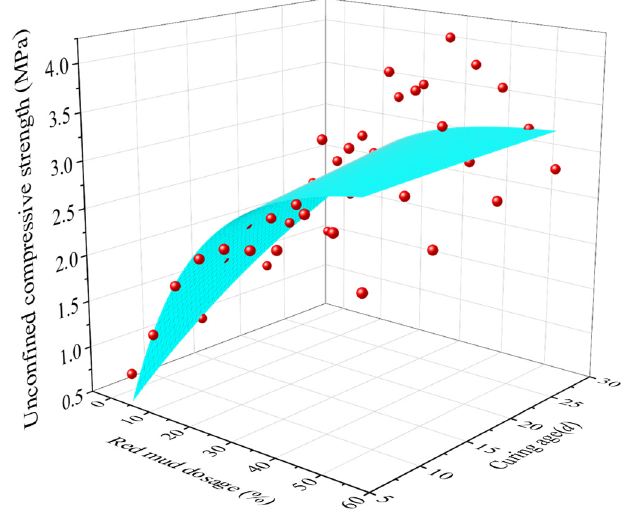
Figure 10. Fitting figure of UCS with different D R and curing age. Table 7. Parameter values for the fitting UCS equation.